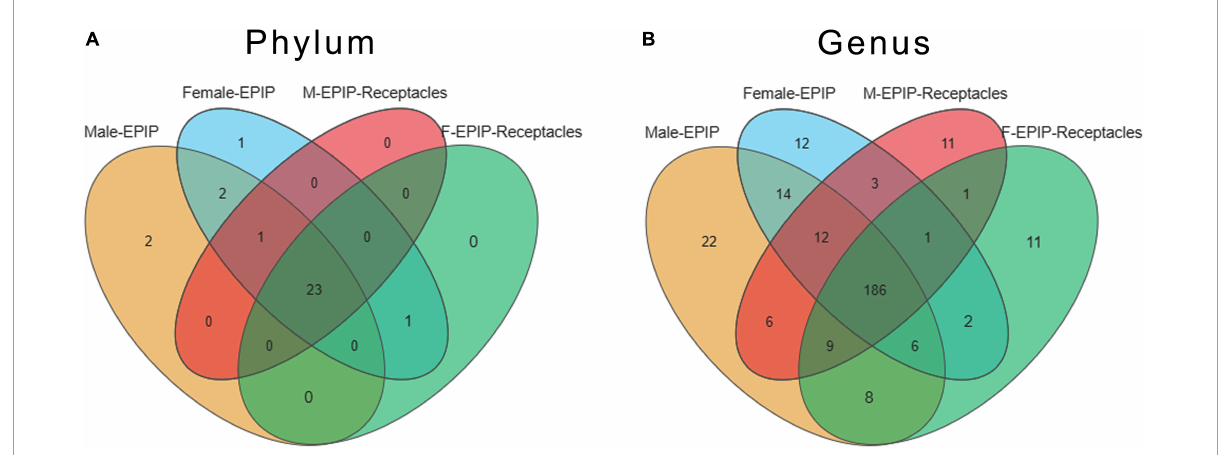
FIGURE3 Venn diagram of epiphytic bacteria on algal bodies and receptacles of male and female S. thunbergii at the phylum and genus levels. (A) Phylum level. (B) Genus level.